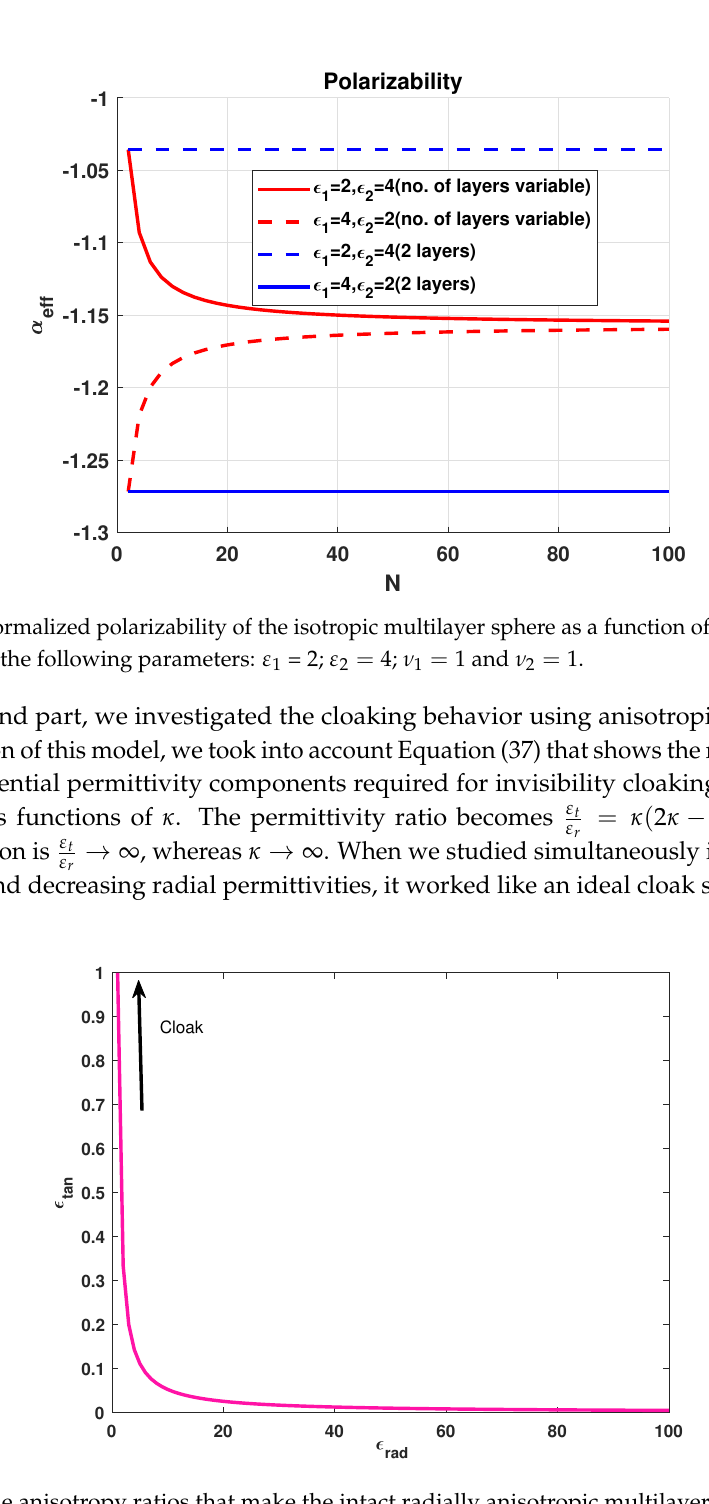
Figure 4. The anisotropy ratios that make the intact radially anisotropic multilayer sphere invisible, Equation (37), plotted on a linear